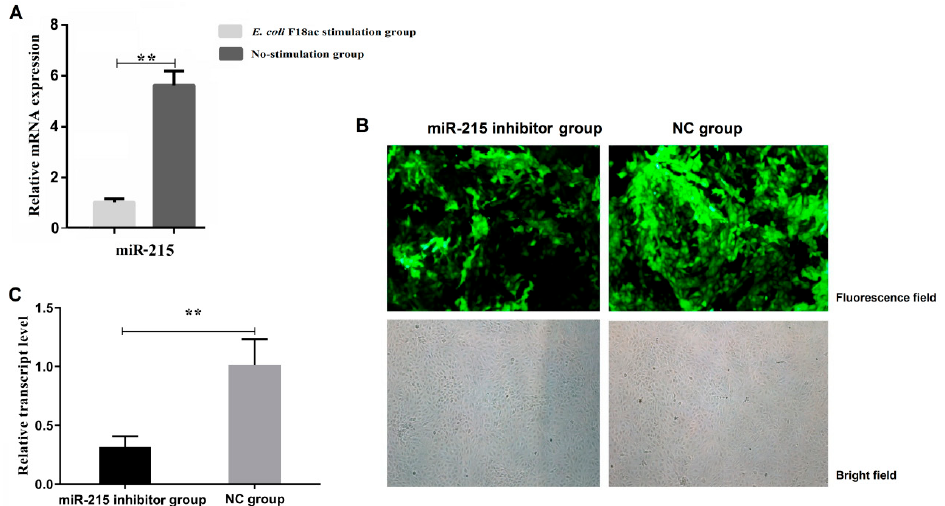
Figure 2. Expression changes of miR-215 in IPEC-J2 cells stimulated by E. coli F18ac and construction of cell line with miR-215 stable interference. ( A ) Transcription level of miR-215 in IPEC-J2 cells between the E. coli F18ac stimulation group and no-stimulation group. ( B ) Expression of green fluorescent protein after IPEC-J2 cells were transfected by lentivirus for 48 h (100×). ( C ) Transcription level of miR-215 after IPEC-J2 cells were transfected by lentivirus for 72 h. ** indicates the significant difference ( p <